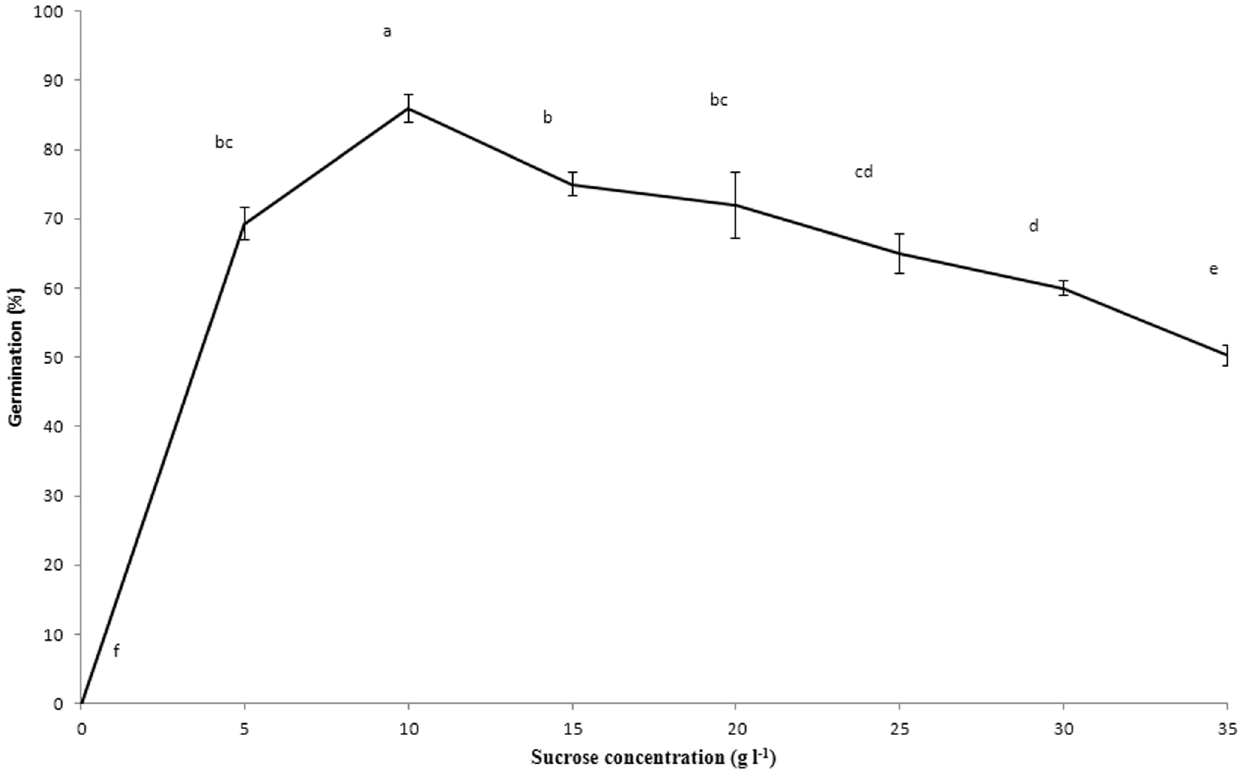
Figure 3. Effect of sucrose concentration on invitro germination of Renantheraimschootiana on quarter-strength MS medium supplemented with 0.5 mg l 2 1 NAA, 20% CW and 1.0 g l 2 1 AC 75 days after culture. Different letters indicate significant differences between days at P , 0.05 (DMRT).